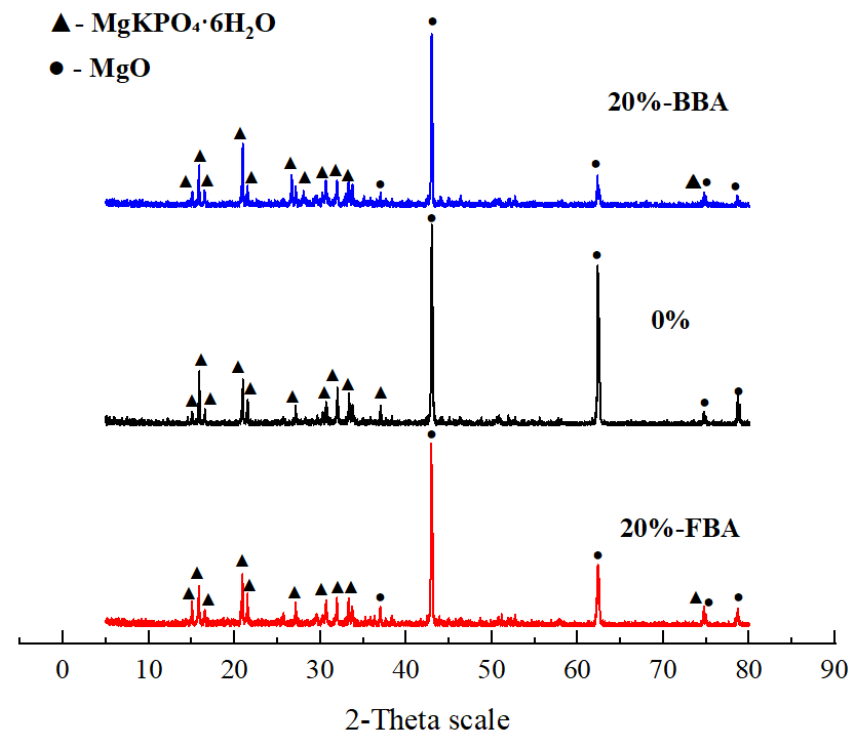
Figure 13. The XRD patterns of BA ‐ MPC paste samples (group 20 BA ‐ 80 MPC) at 28 days.